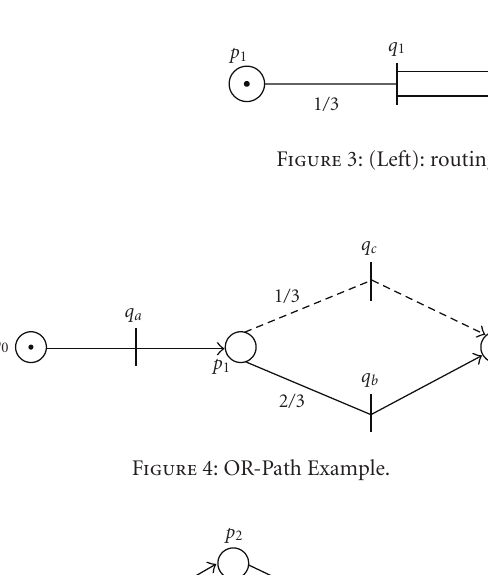
Figure 5: AND-path